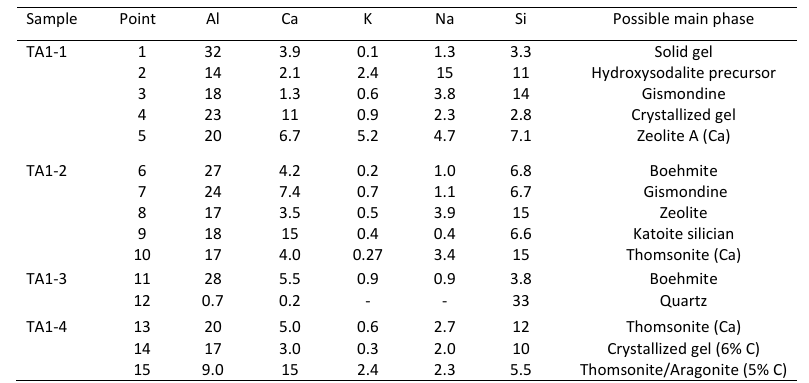
Figure 10. Scanning electron micrographs and point compositions of typical cement microstructures for TSRC specimens with 1% by weight of blend TA.